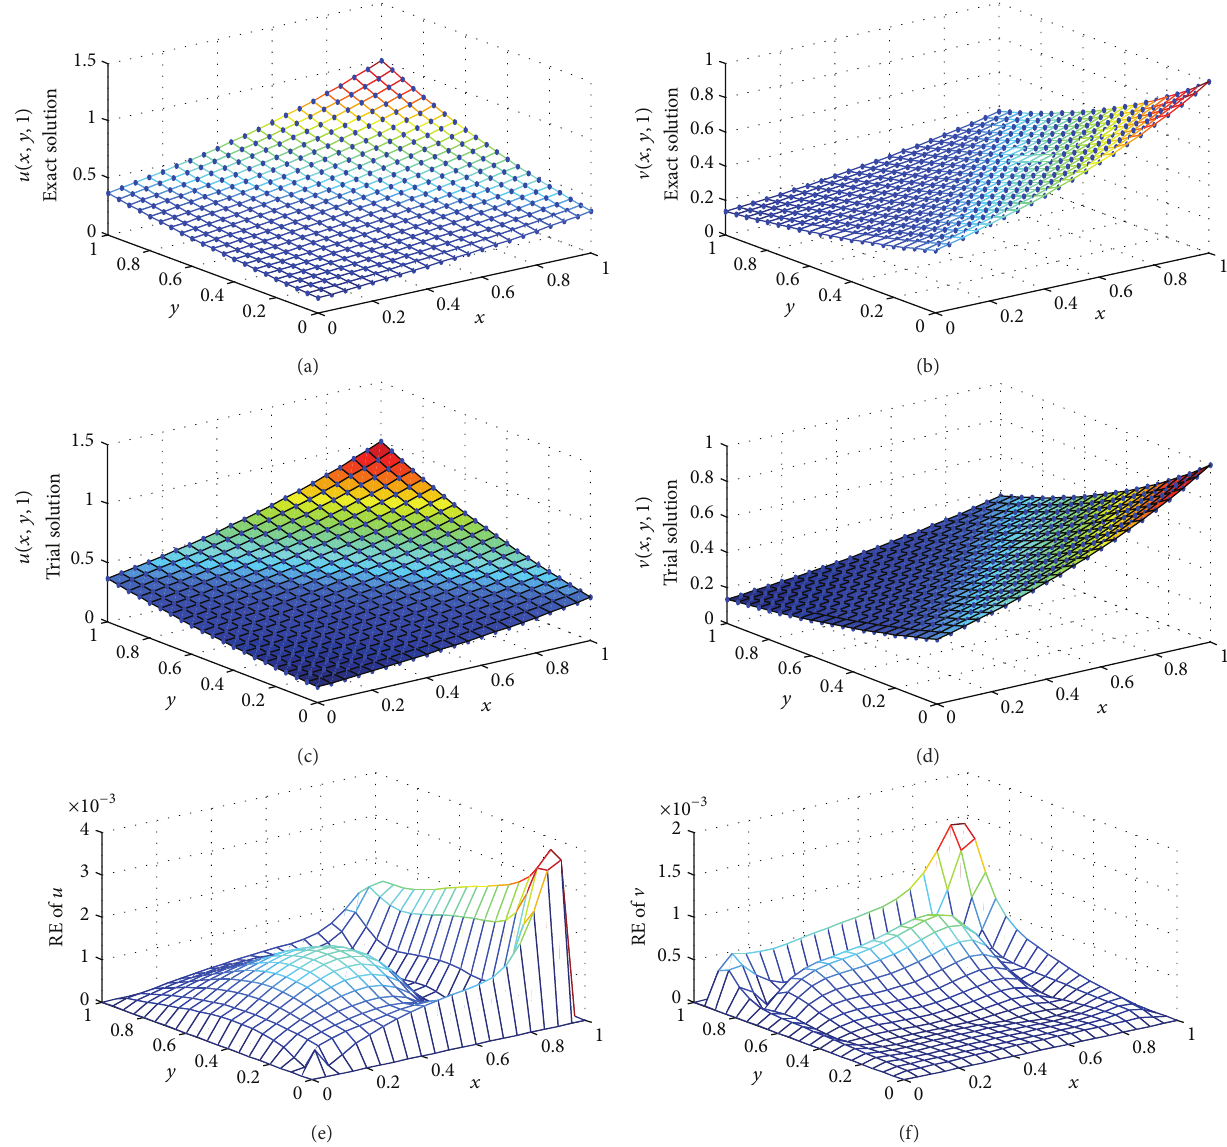
Figure 3: Exact and trial solutions of 𝑢 and V using 𝑁 = 441 , 𝑚 = 10 , 𝑡 = 1 , and Δ𝑡 = 0.1 . (a) exact solution of 𝑢 ; (b) exact solution of V ; (c) trial solution of 𝑢 ; (d) trial solution of V ; (e) corresponding error profile of 𝑢 ; (f) corresponding error profile of V .